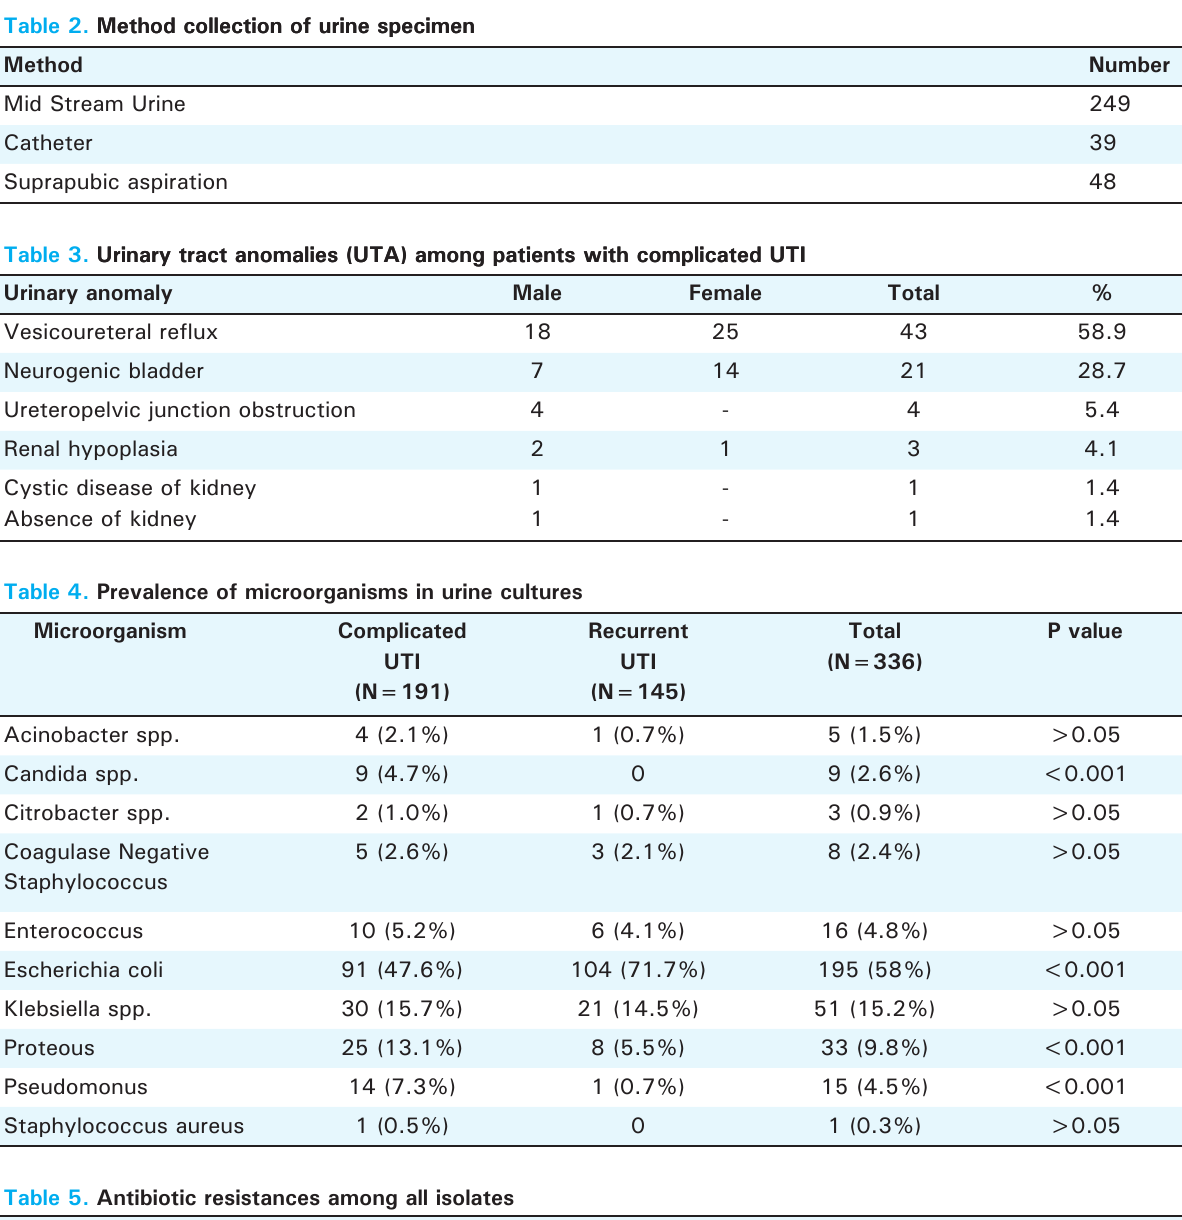
table 5. Antibiotic resistances among all isolates